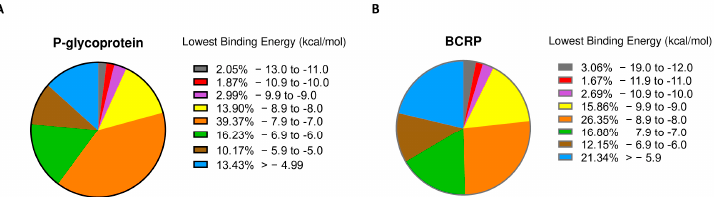
Figure 1. PyRx docking. Pie charts illustrating the percentage of compounds within a specific range of lowest binding of P-glycoprotein ( panel A ) and BCRP ( panel B ).